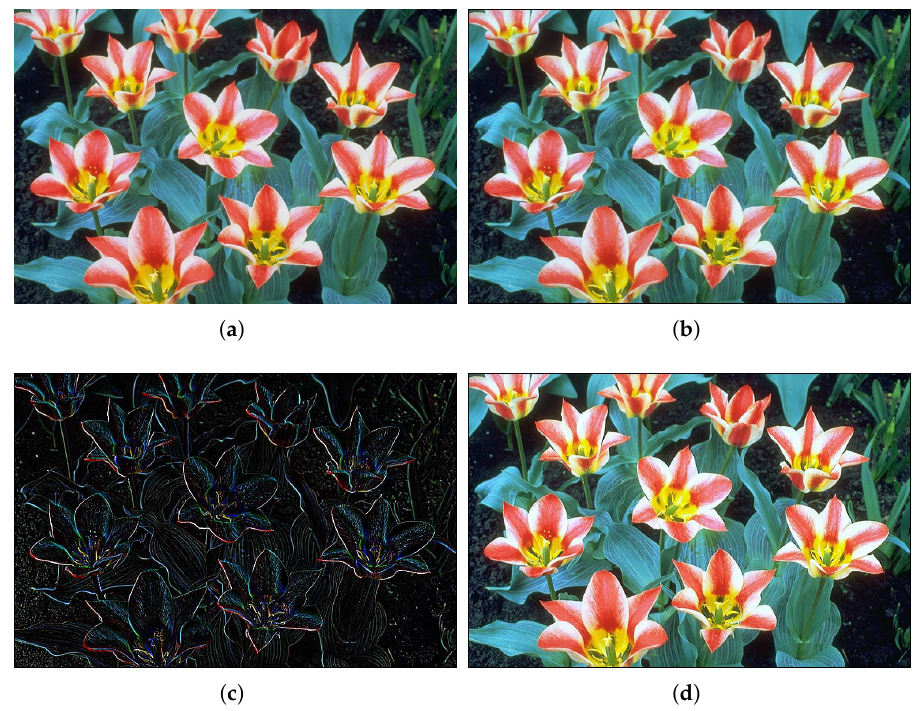
Figure 11. Example 3: Color figure, showing the sharpening results obtained using the proposed stochastic computing CNN. ( a ) Original image. ( b ) Stored image. ( c ) Edge detection result. ( d ) Sharp- ened